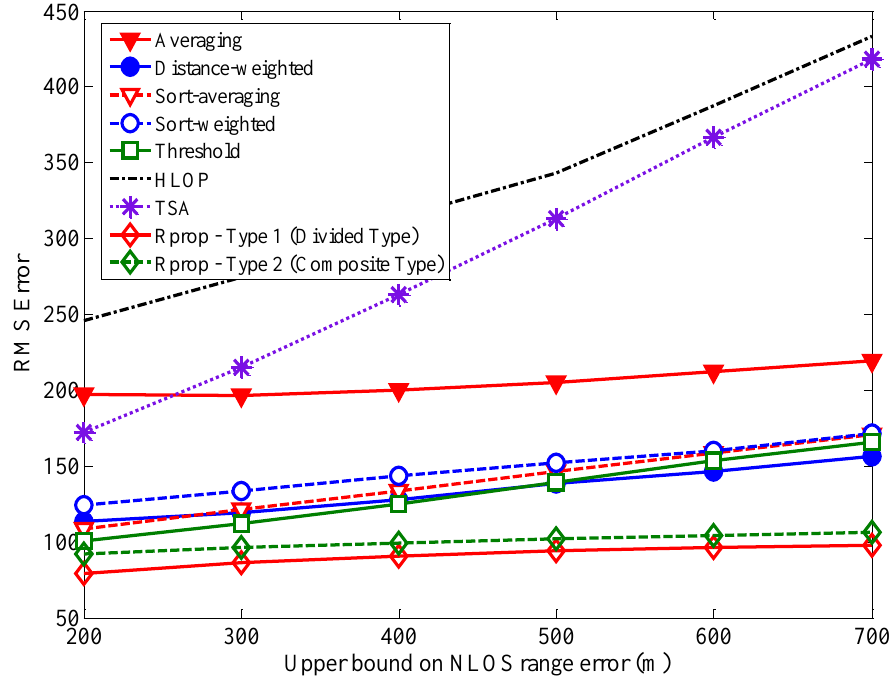
Figure 9. Performance comparison of the location estimation methods when the upper bound is used to model the